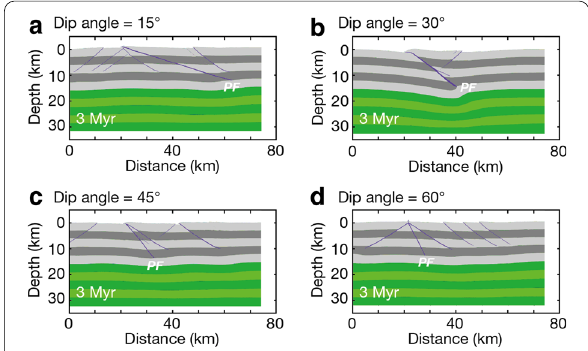
Fig. 8 Results for numerical simulations with a single preexisting fault zone. The preexisting fault (PF) and the newly formed faults 3 (markers with a cumulative strain larger than 1) are illustrated in dark = blue. The weakened friction coefficient μ w is ~ 0.5 (weakened friction angle φ w 27°). a Case with a dip angle of 15°. b Case with a dip = angle of 30°. c Case with a dip angle of 45°. d Case with a dip angle of